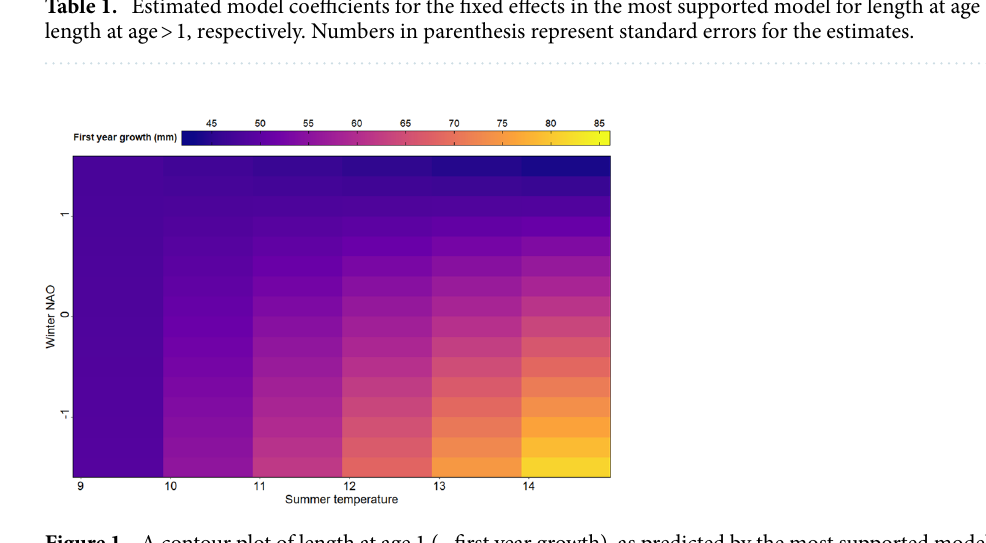
Figure 1. A contour plot of length at age 1 (~ first year growth), as predicted by the most supported model. Predicted length at age 1 in mm, as indicated by the variation in colour, is shown as functions of air summer temperature (x-axis) and winter NAO-index value (y axis). The figure has been made using the ggplot2-library 68